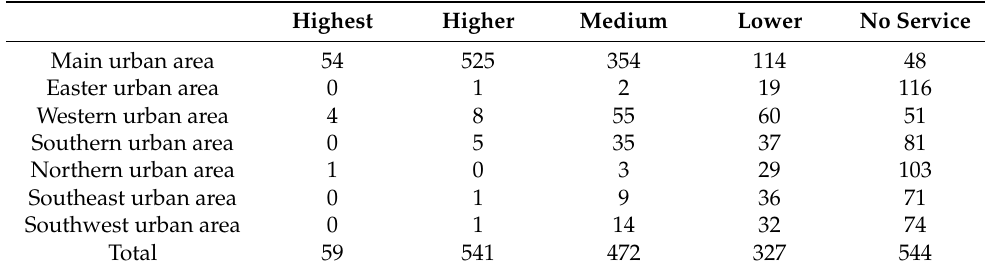
Table 5. Statistics of residents’ supply service level in different urban